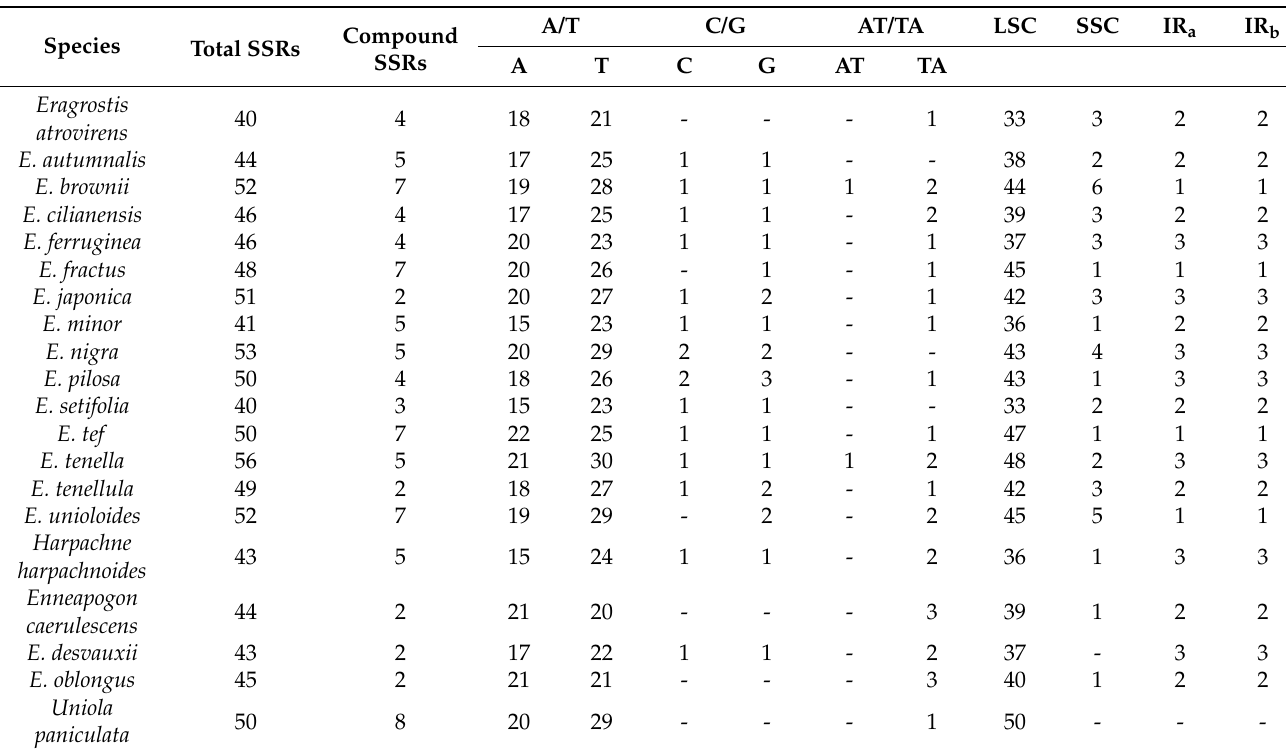
Table 3. Numbers of SSRs in 20 Eragrostideae chloroplast